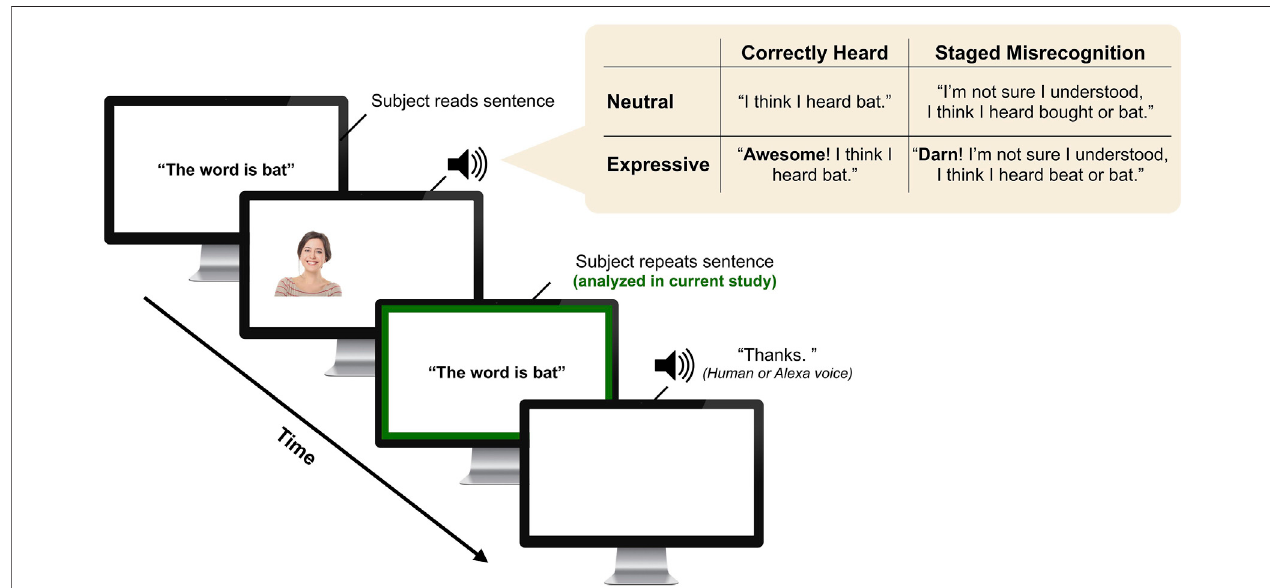
FIGURE 1 | Interaction trial schematic. After participants read a sentence, the interlocutor (human or Alexa) responds in one of the Staged Misunderstanding Conditions (correctly heard, misrecognition) and Emotionality Conditions (neutral, emotionally expressive). Then, the subject responds (the production we analyze). Finally, the interlocutor provides a follow-up